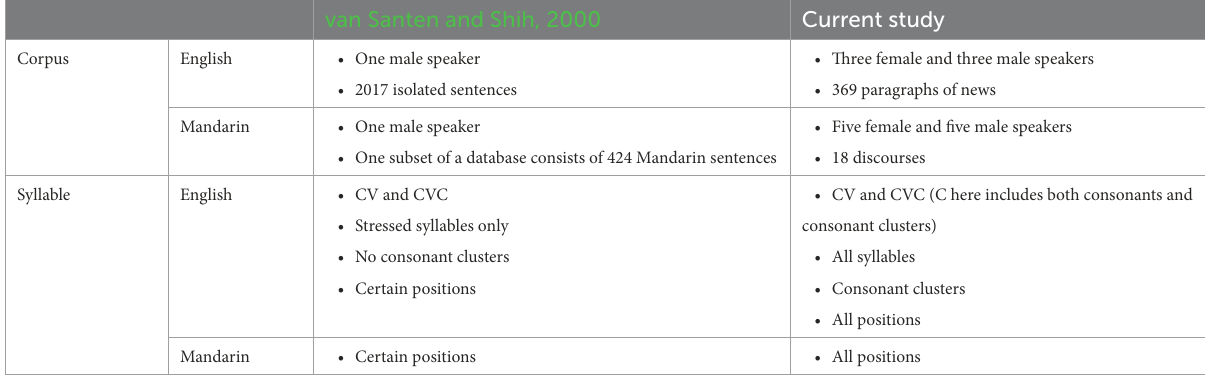
TABLE 1 Differences between van Santen and Shih’s, 2000 and current study.